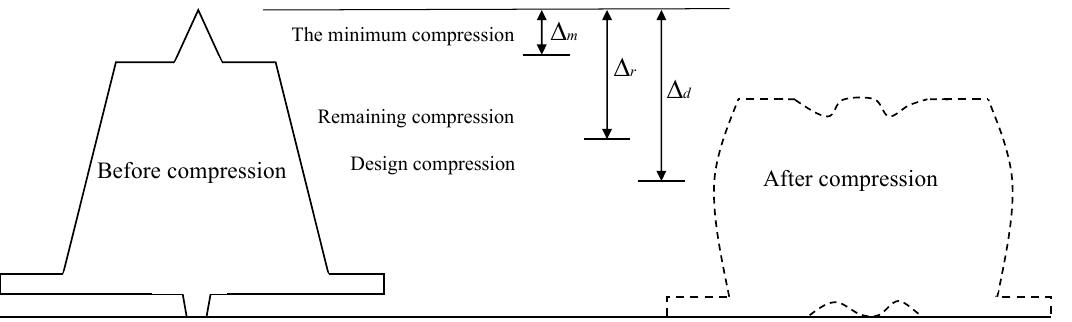
Figure 7. The relationship of compression characteristics of GINA gasket (redrawn according to Liu et al. [25]).